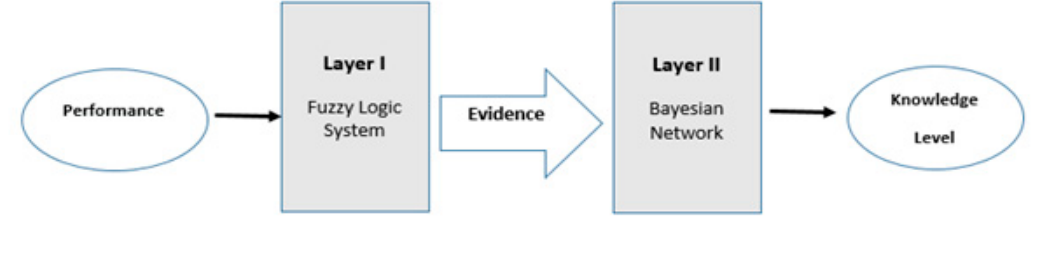
Figure 2. Student model of FB ‐ ITS.